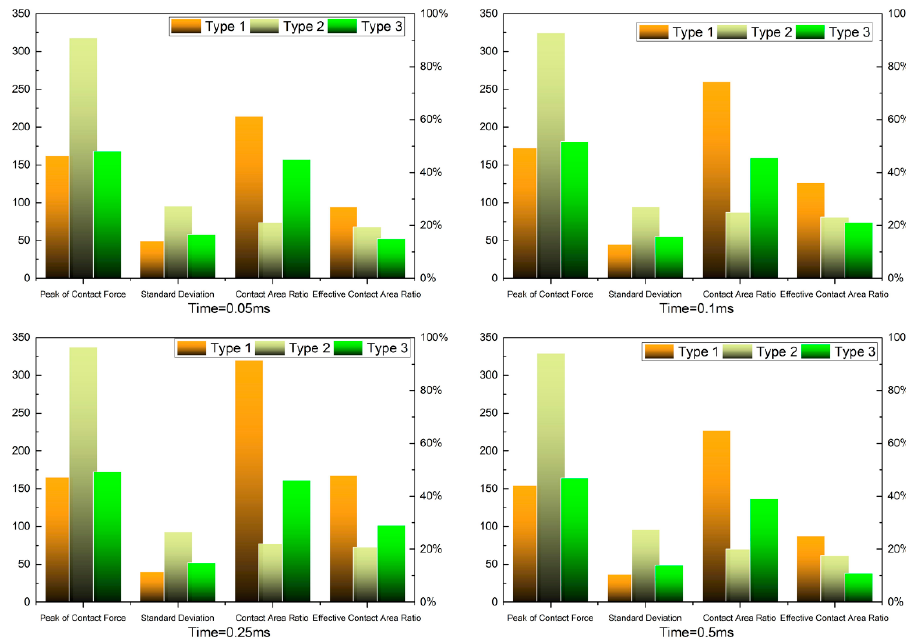
Figure 11. Contact parameters of the three types of rail.